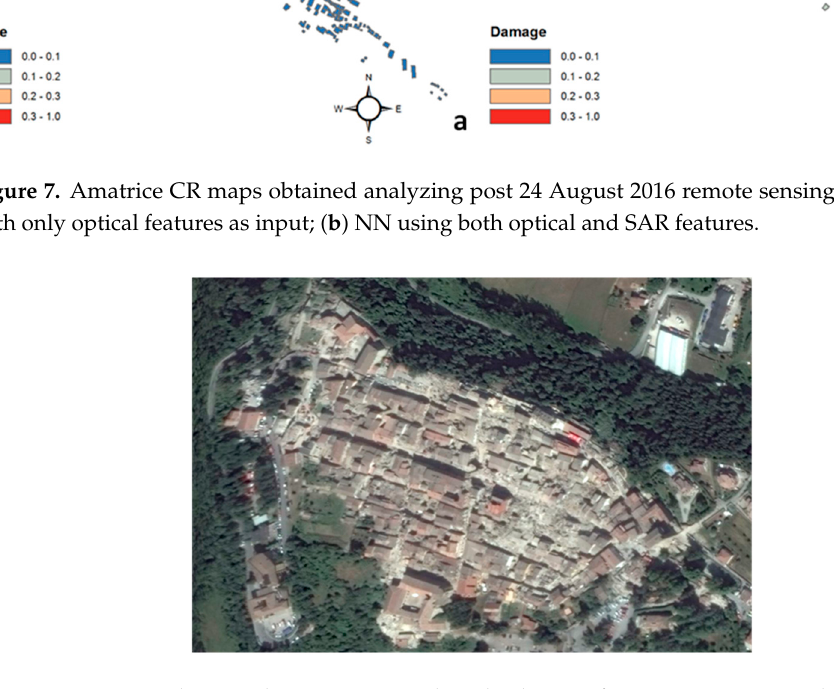
Figure 7. Amatrice CR maps obtained analyzing post 24 August 2016 remote sensing data: ( a ) NN with only optical features as input; ( b ) NN using both optical and SAR features.